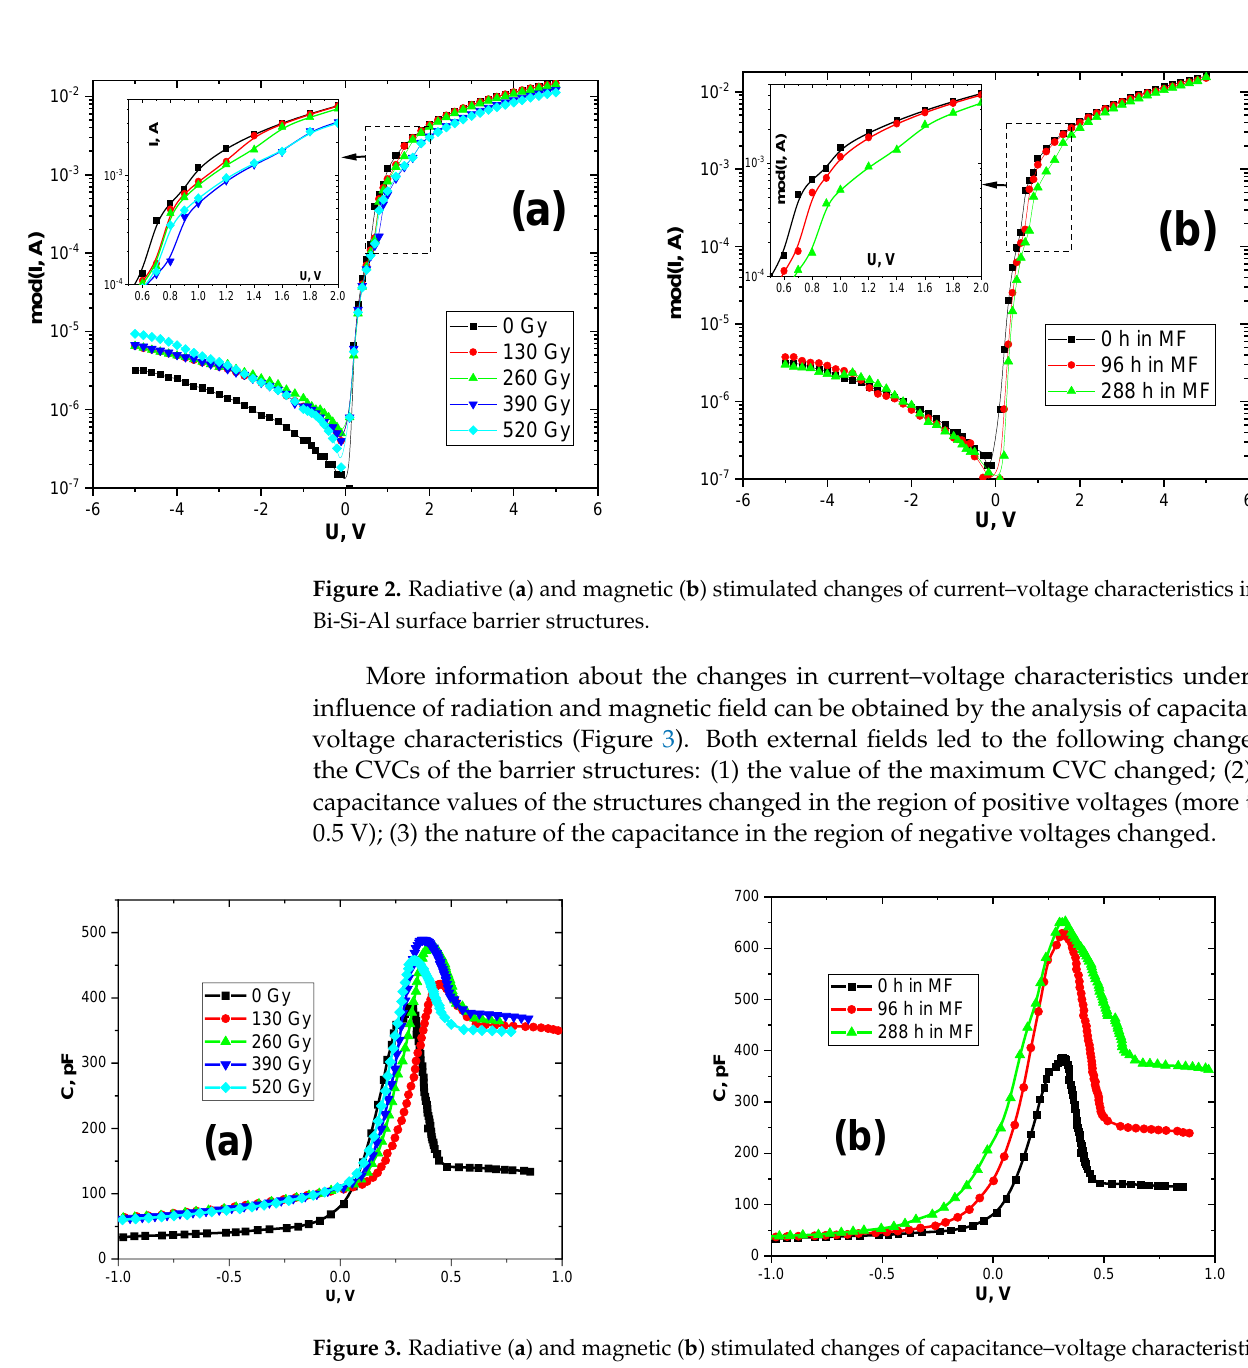
Figure 3. Radiative ( a ) and magnetic ( b ) stimulated changes of capacitance – voltage characteristics in the Bi-Si-Al surface barrier structures.